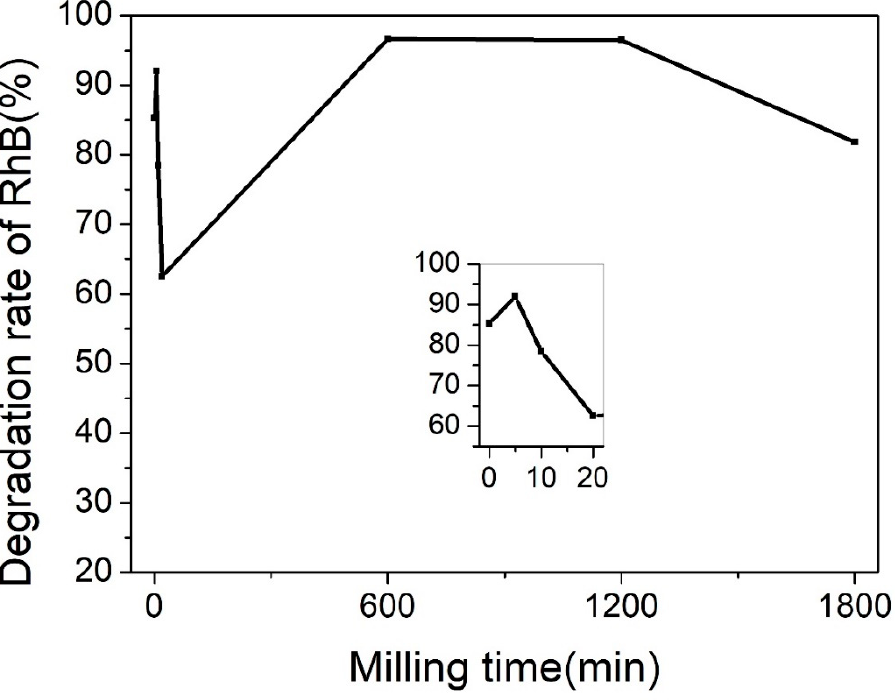
Figure 6. Photocatalytic activity of ZnO samples with different milling time. The rate of RhB degradation treated with the A2, A3, and A4 photocatalysts for differ- ent high-energy ball milling times was faster than that using the samples calcined directly without high-energy ball milling, as shown in Figure 7a. Among them, the degradation rate of the A3 photocatalyst was highest, up to 96.63% in 60 min under a simulated light source. On the other hand, the A1 photocatalyst without high-energy ball milling could only degrade 78.70% of RhB under the same conditions. The bandgap of all ZnO products was between 3.108 and 3.123 eV. High-energy ball milling promotes the photocatalytic modification of ZnO because the entropy and particle size of the A3 sample reached the limits of high-energy ball milling. Moreover, defects can become a trap of photogenerated electrons, inhibiting the composite of photogenerated charges of materials, promoting their separation, and enhancing the photocatalytic performance. The extremely small particle size and various crystal surfaces exposed also provide a large number of reaction sites for the photocatalytic reaction. Figure 7b,c show the degradation rate constants calculated using the degradation rate formula, ln ( C / C 0 ) = kt . The first order rate constants ( k ) for the degradation of RhB using the A3 photocatalyst was 0.05781 min − 1